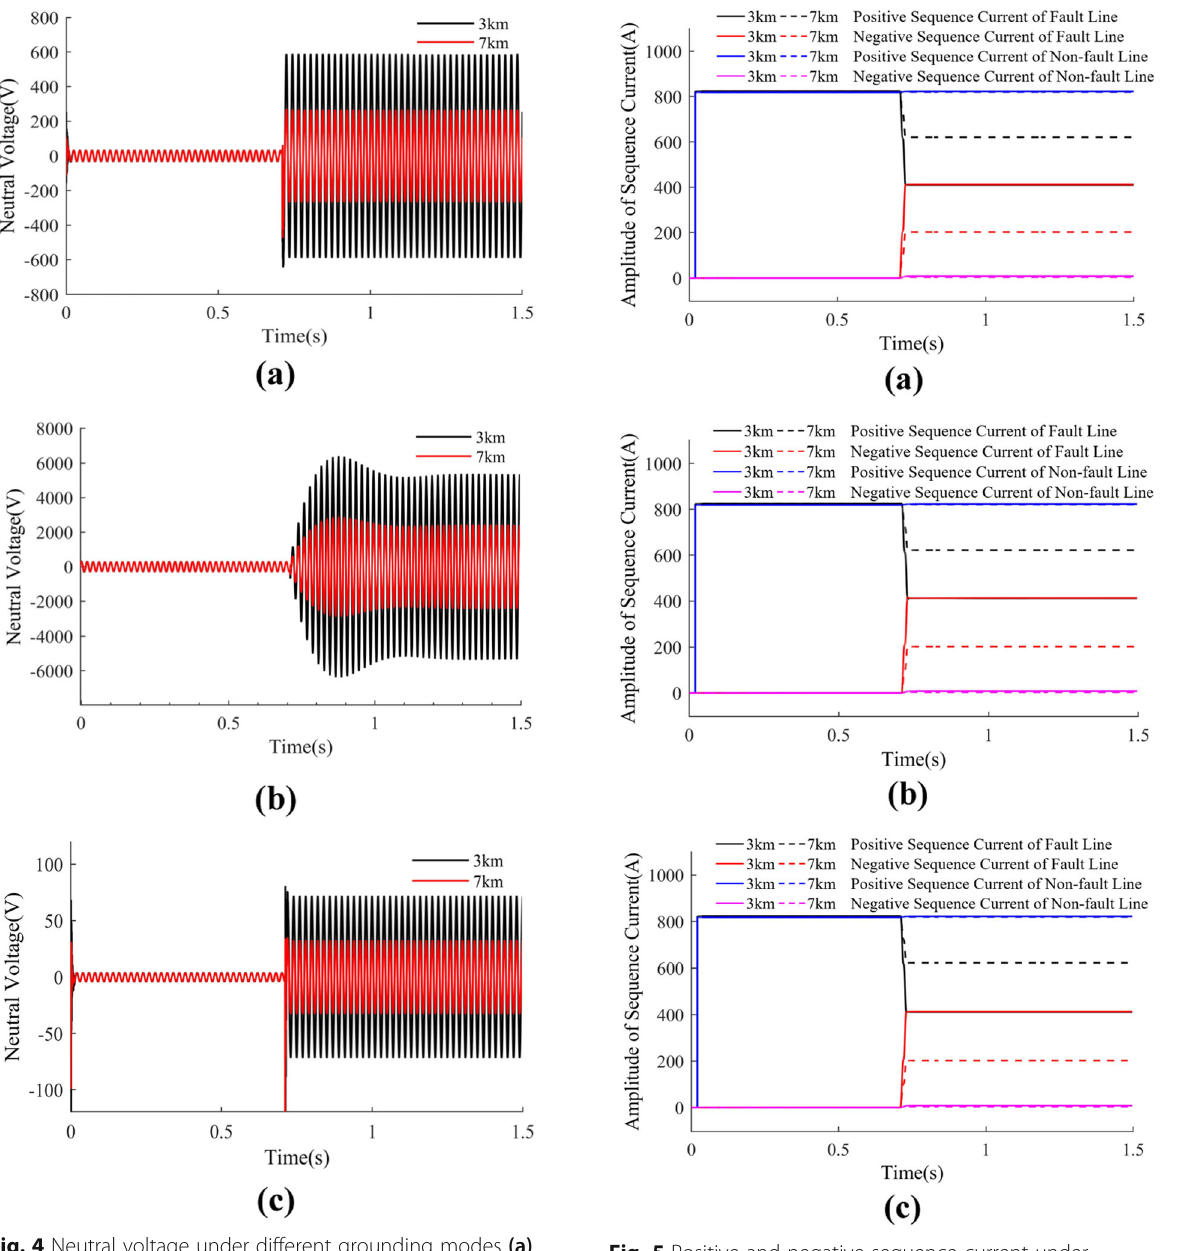
Fig. 4 Neutral voltage under different grounding modes (a) Ungrounded (b) Arc suppression coil grounded (c) Low resistance grounded